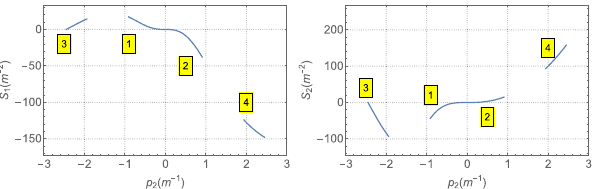
FIG. 5. The sextupole strengths of the four solutions vs the second quadrupole strength.